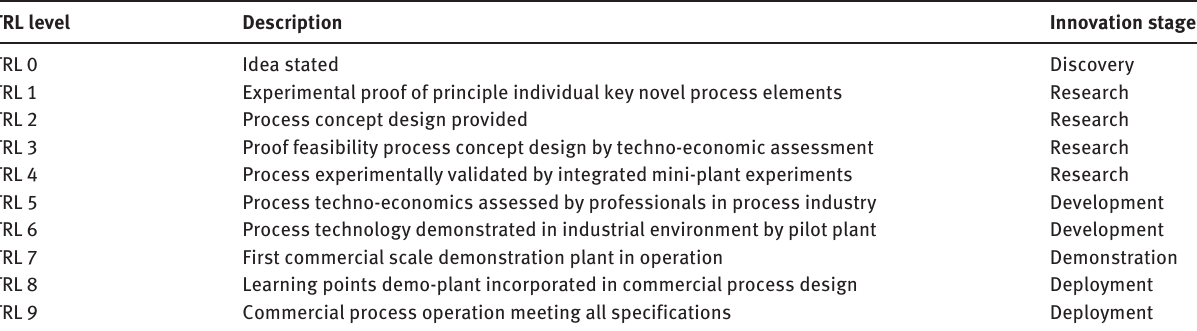
Table 1 Technology readiness level (TRL) definitions for process technologies. TRL